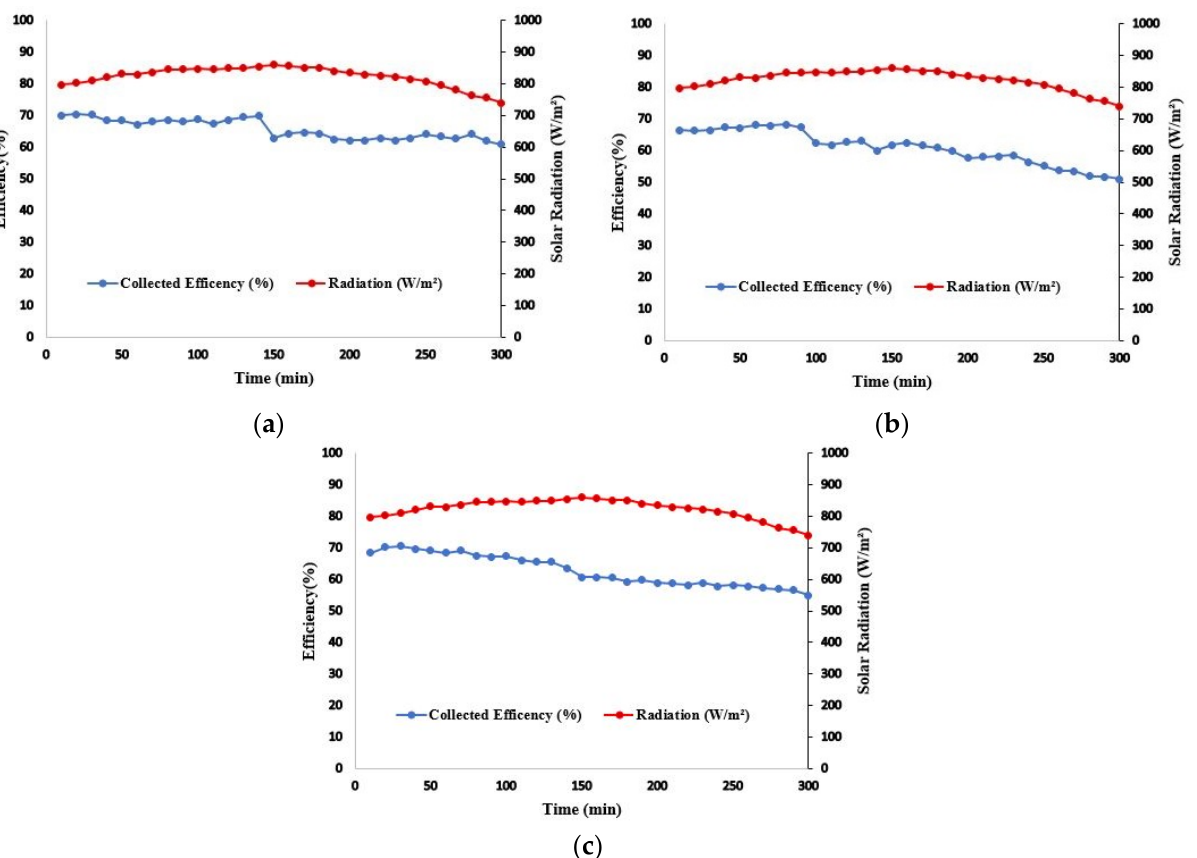
Figure 3. Collected efficiency using ( a ) Al 2 O 3 , ( b ) CuO, and ( c ) distilled water at 4 L/min .